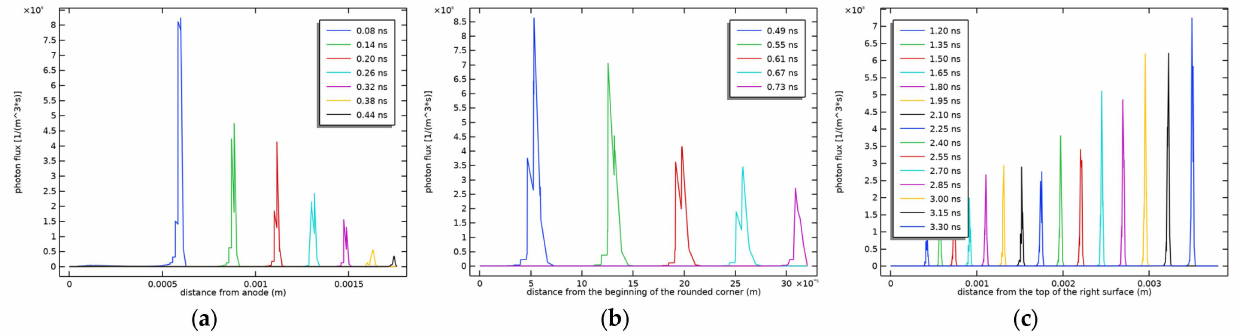
Figure 17. Variation in photon flux of the streamer head in SF 6 . ( a ) Stage 1; ( b ); Stage 2 ( c ); Stage